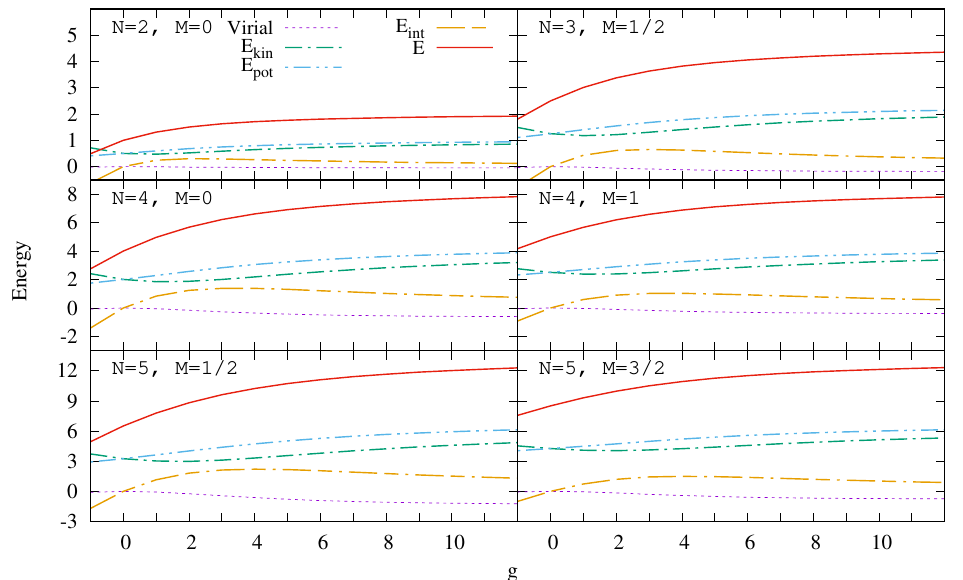
Figure 4. Different energy contributions to the total ground-state energy, as a function of the interaction strength for different number of particles and total third-spin component. The total energy and the fulfilment of the virial theorem is also shown (Equation (47)). The legend is common to all